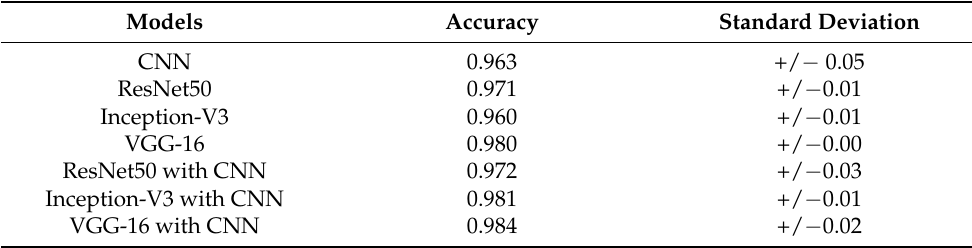
Table 7. Results of 10-fold cross-validation for individual and ensemble models.